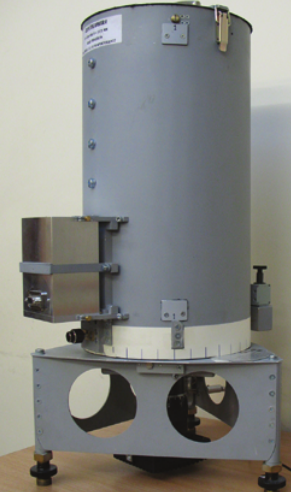
Fig. 1. Prototype zenith